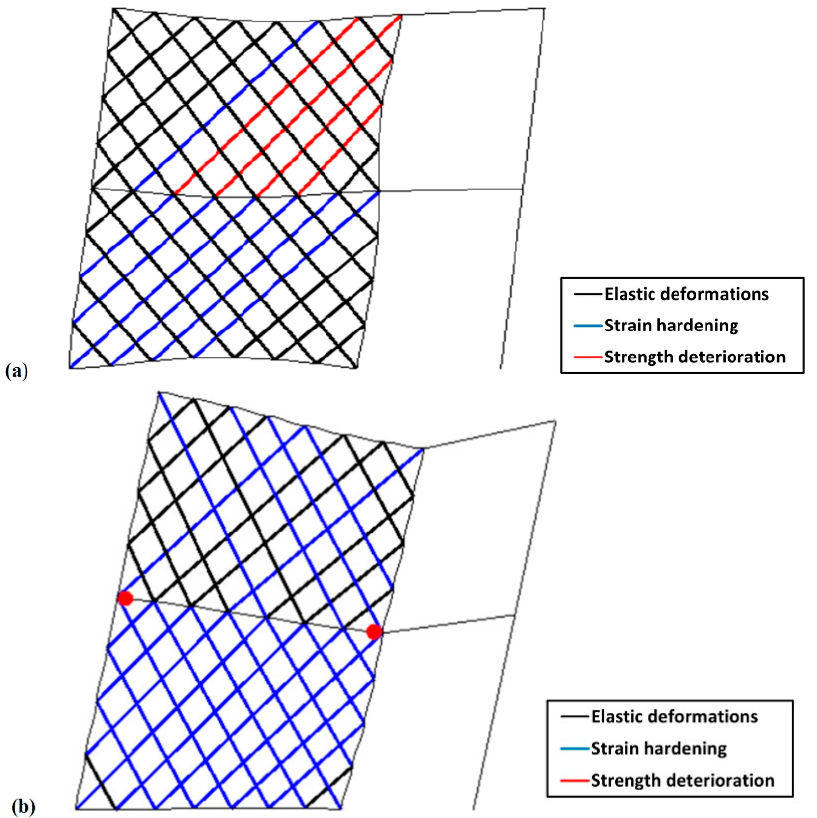
Figure 13. Visualizing the failure mechanism in INSPECT-SPSW; ( a ) web tearing failure; ( b ) frame flexural deterioration failure.